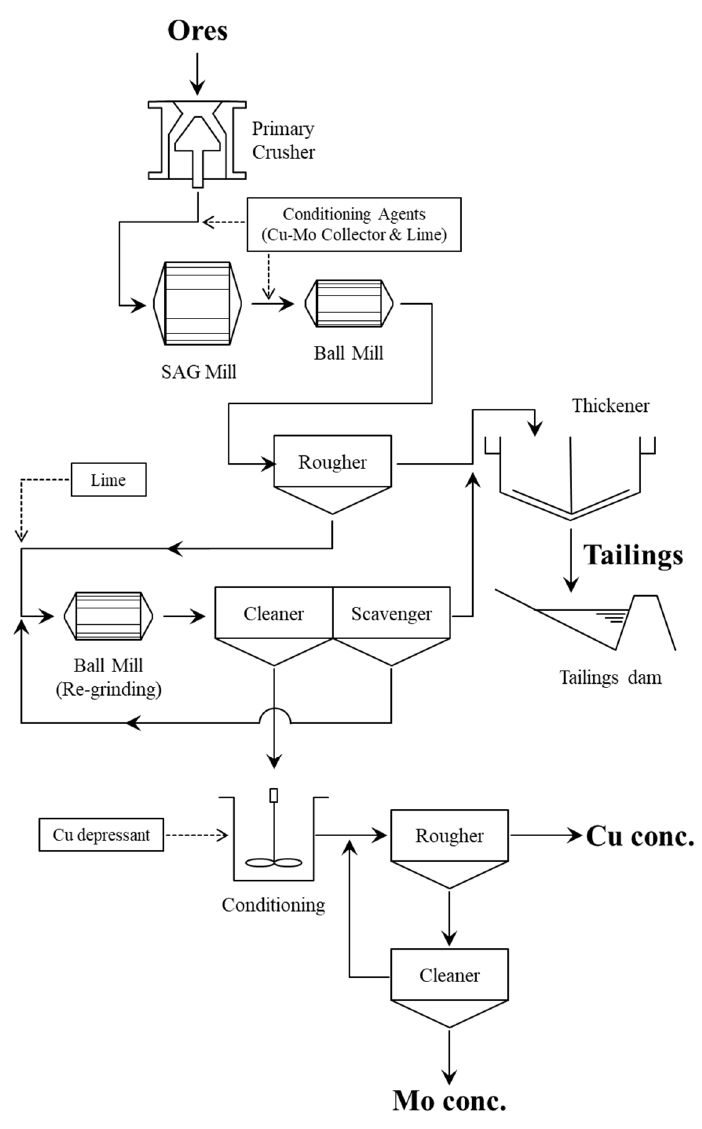
Figure 2. Beneficiation flowsheet of Cu–Mo sulfide ores [7].